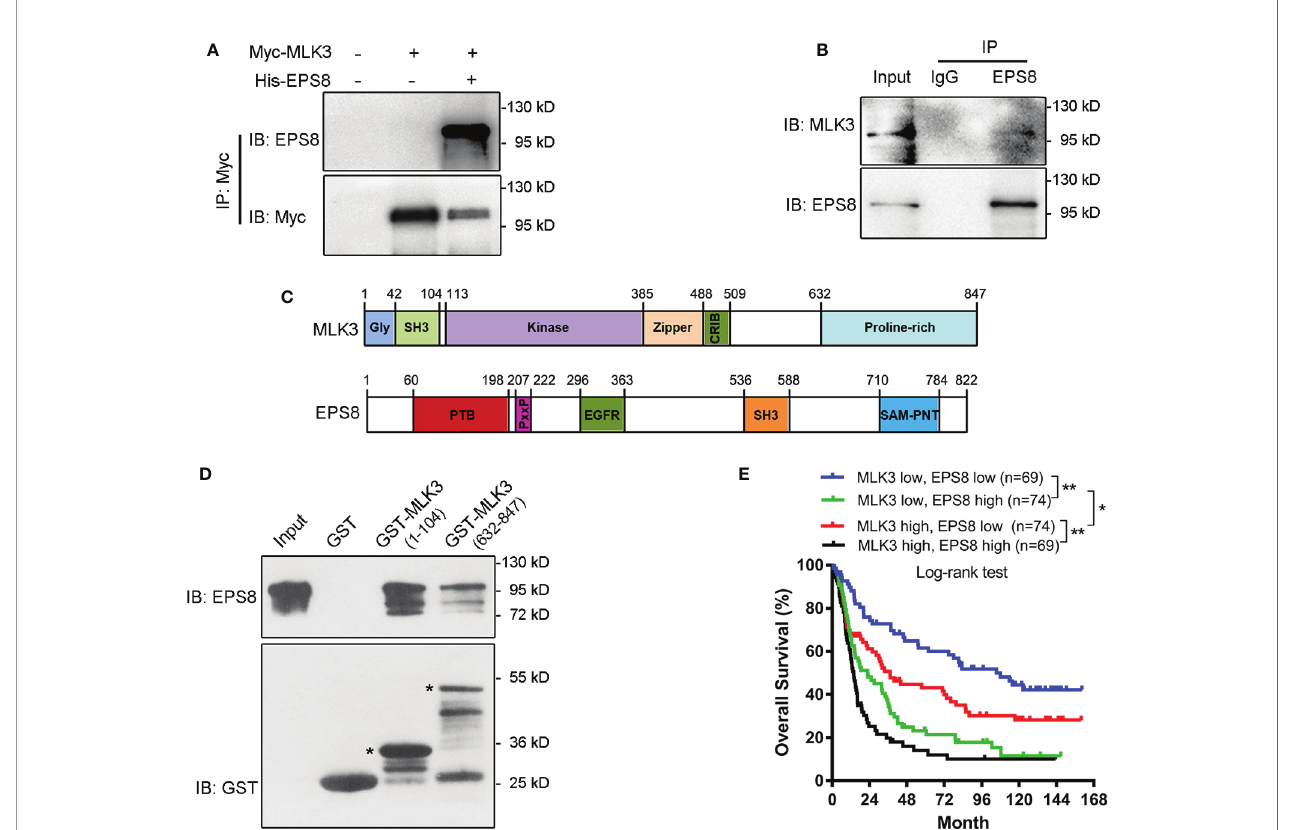
FIGURE 4 | MLK3 directly binds with EPS8. The results shown are representative of at least three independent experiments. (A, B) Overexpressed and endogenous MLK3 binds to EPS8 in U251 cells. U251 cells were cotransfected with pcDNA3.1-Myc-MLK3 and pcDNA3.1-His-EPS8 plasmids for 24 h, with the pcDNA3.1 plasmid as a control. The lysates were immunoprecipitated using anti-Myc (A) , anti-EPS8 (B) or control IgG, EPS8, or MLK3 was detected with an immunoblot assay. (C) The molecular structure of MLK3 and EPS8. (D) AAs 1 – 104 and 632 – 847 of MLK3 directly bound to EPS8 in vitro . GST-tagged MLK3 segments were expressed in BL21 cells. The puri fi ed proteins were incubated with the protein lysates from pcDNA3.1-EPS8-transfected HEK293 cells. The proteins were immunoblotted with indicated antibodies. * the target protein. (E) The expression of MLK3 and EPS8 predicts the overall survival of patients. The data were derived from the CGGA dataset (n = 286). Kaplan-Meier survival analyses for MLK3 and EPS8 mRNA levels. Log-rank test. * P < 0.05, ** P <